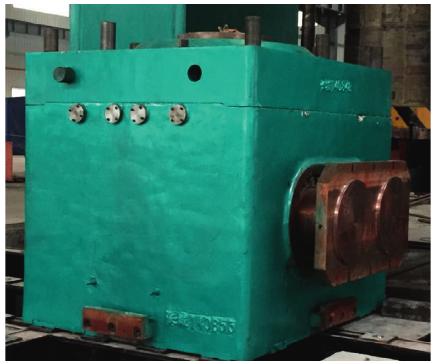
Figure 3: Sealed cabin.